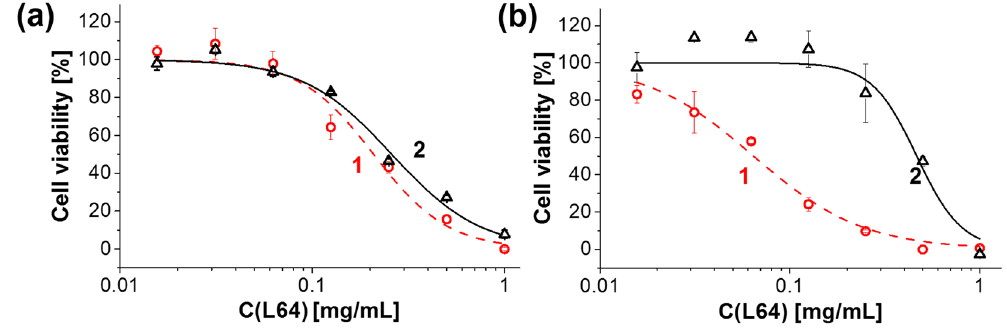
Figure 5. Interaction of CLD with MCF-7/ADR cells. Dose-response survival curves of MCF-7/ADR cells either untreated ( a ), or pretreated with 200 μ M H 2 O 2 ( b ) in the presence of complete CLD (1) and reference dispersion deprived of TMHP